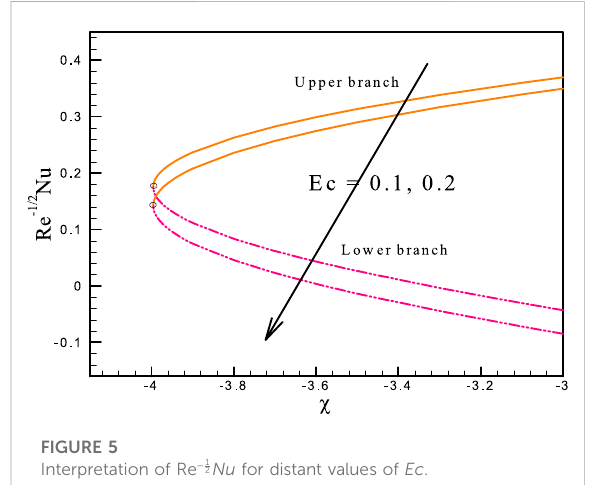
FIGURE 7 Interpretation of f ′ ( η ) for ϕ 1 values of S .